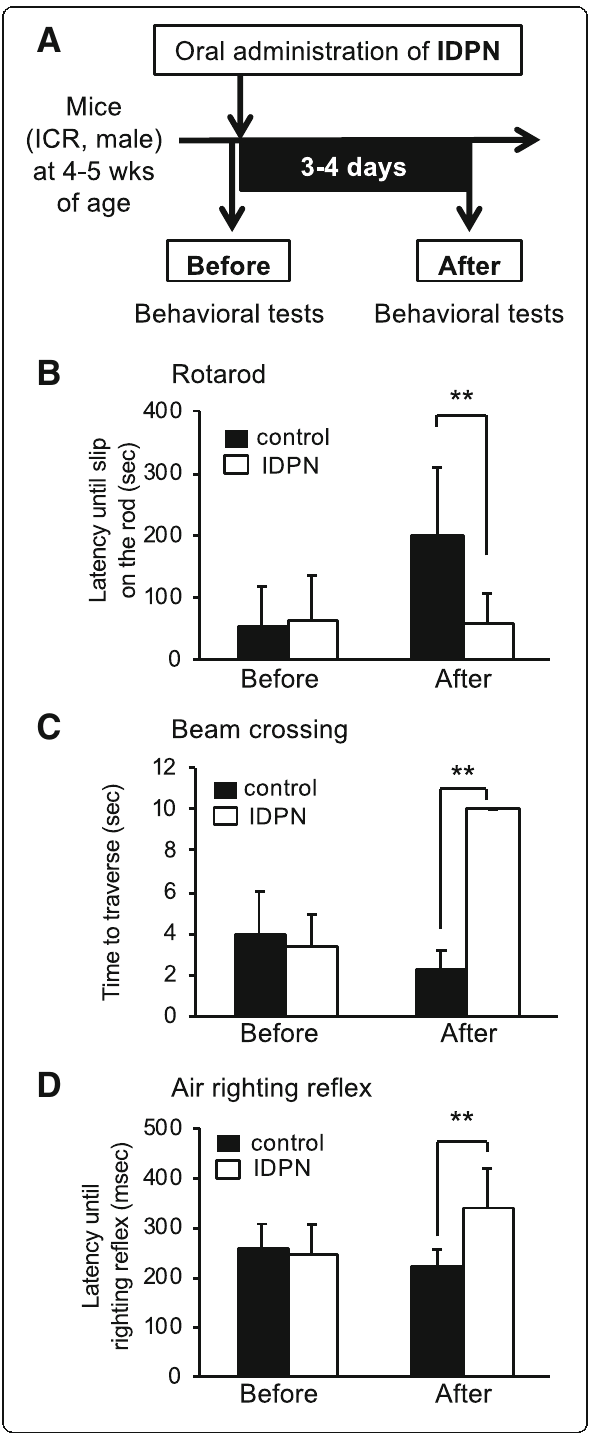
Fig. 1 Balance impairments of mice treated with IDPN and a scheme of experiments. a Scheme of experiments. Behavioral tests were performed with 4 – 5 aged male mice following oral administration of IDPN. The control group ( n =5) and the IDPN group ( n =5) were subjected to behavioral tests after administration of IDPN. b A rotarod test, c a beam crossing test, and d an air-righting reflex test were performed before and 3 – 4days after administration of IDPN (28mmol/ kg) to wild-type mice having an ICR background. b Latency until falling or slipping on the rotarod (seconds, mean±SD), c time to traverse (seconds, mean±SD), and d latency until righting reflex (milliseconds) were recorded for the control group (black bars, n =5) and the IDPN group (white bars, n =5). For the beam crossing test, a score of 10s was given for mice that could not walk on the beam anymore because of complete loss of balance. Significant differences (** p <0.01) between the two groups were analyzed by two-tailed Student ’ s t